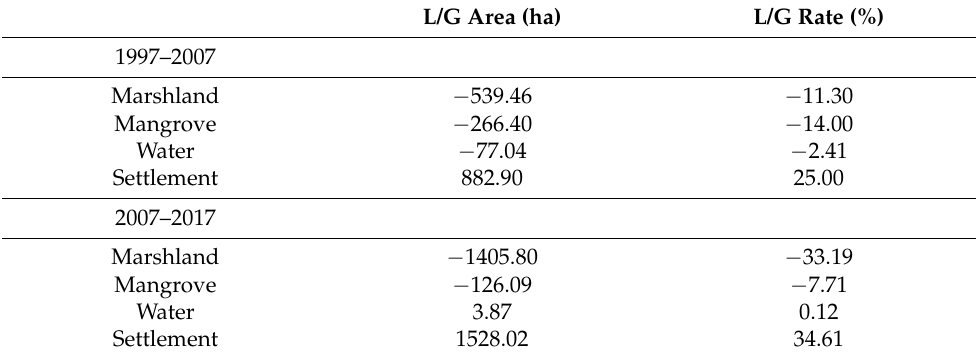
Table 4. Losses and gains of the LUC classes in the